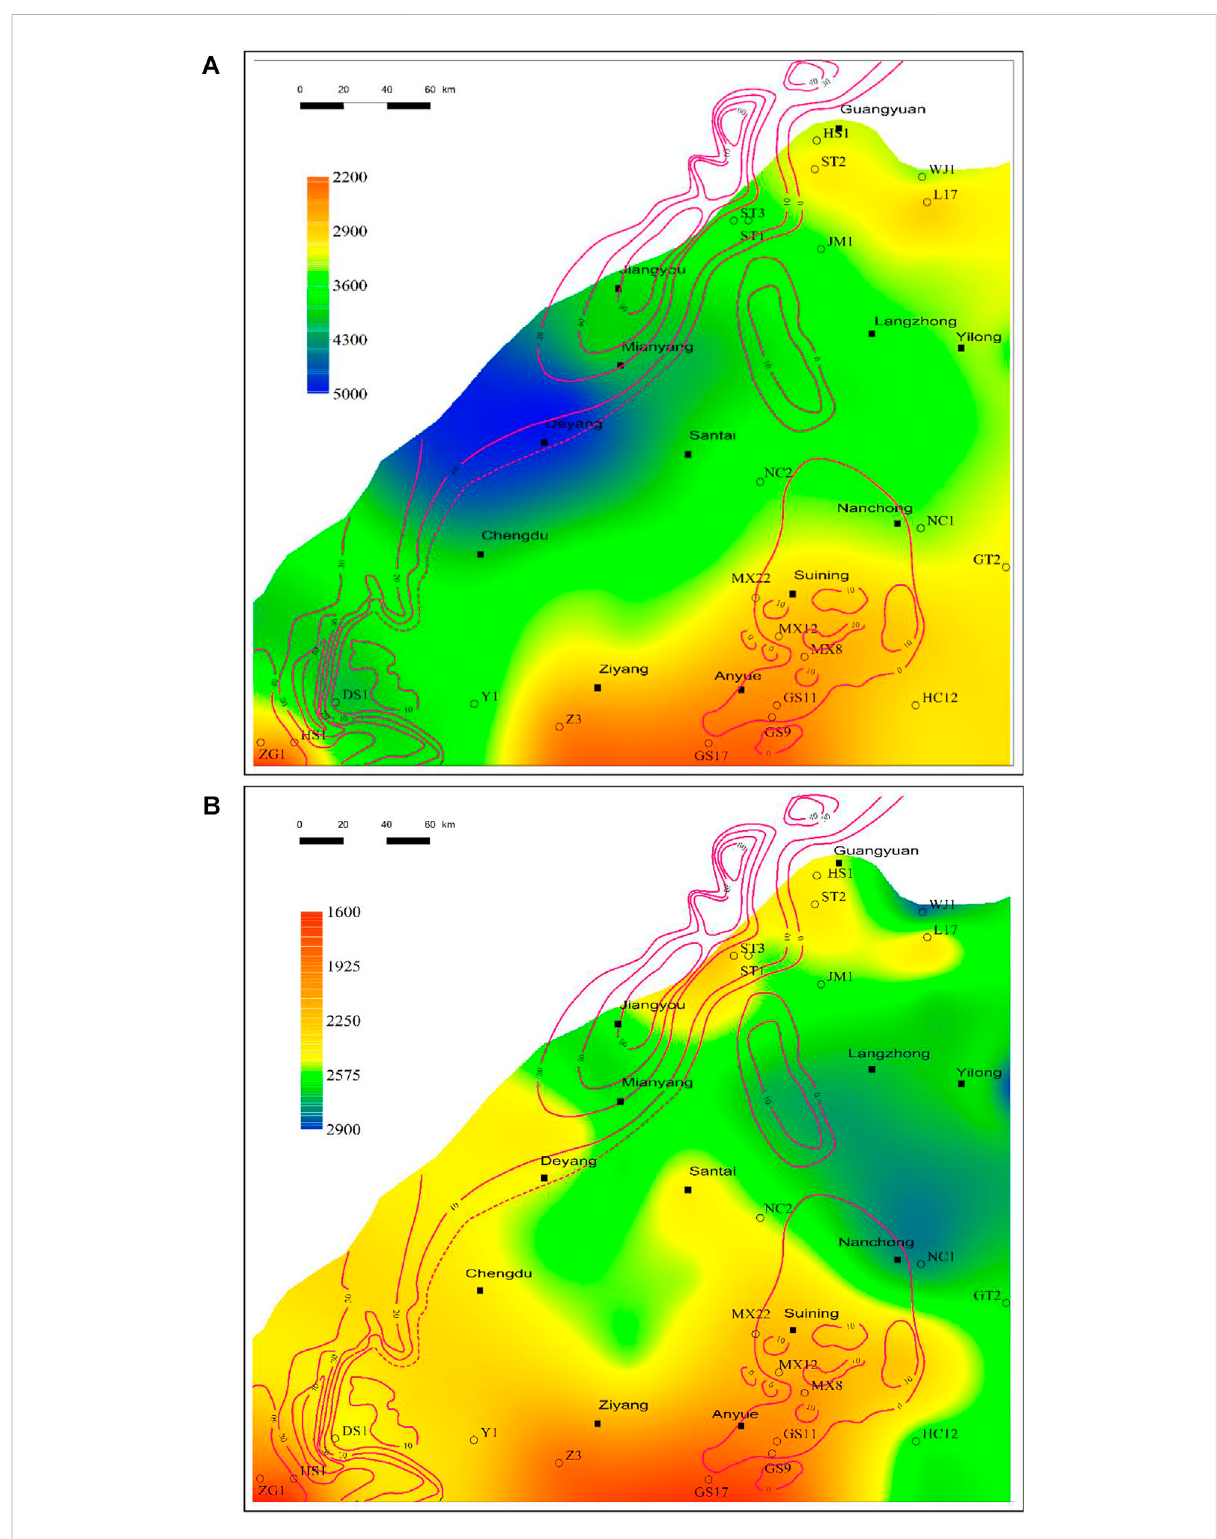
FIGURE 11 (A) Contour map of a dolomite thickness superimposed palaeo-structure of the Qixia Formation at Late Middle Triassic. (B) Contour map of a dolomite thickness superimposed palaeo-structure of the Qixia Formation at the end of